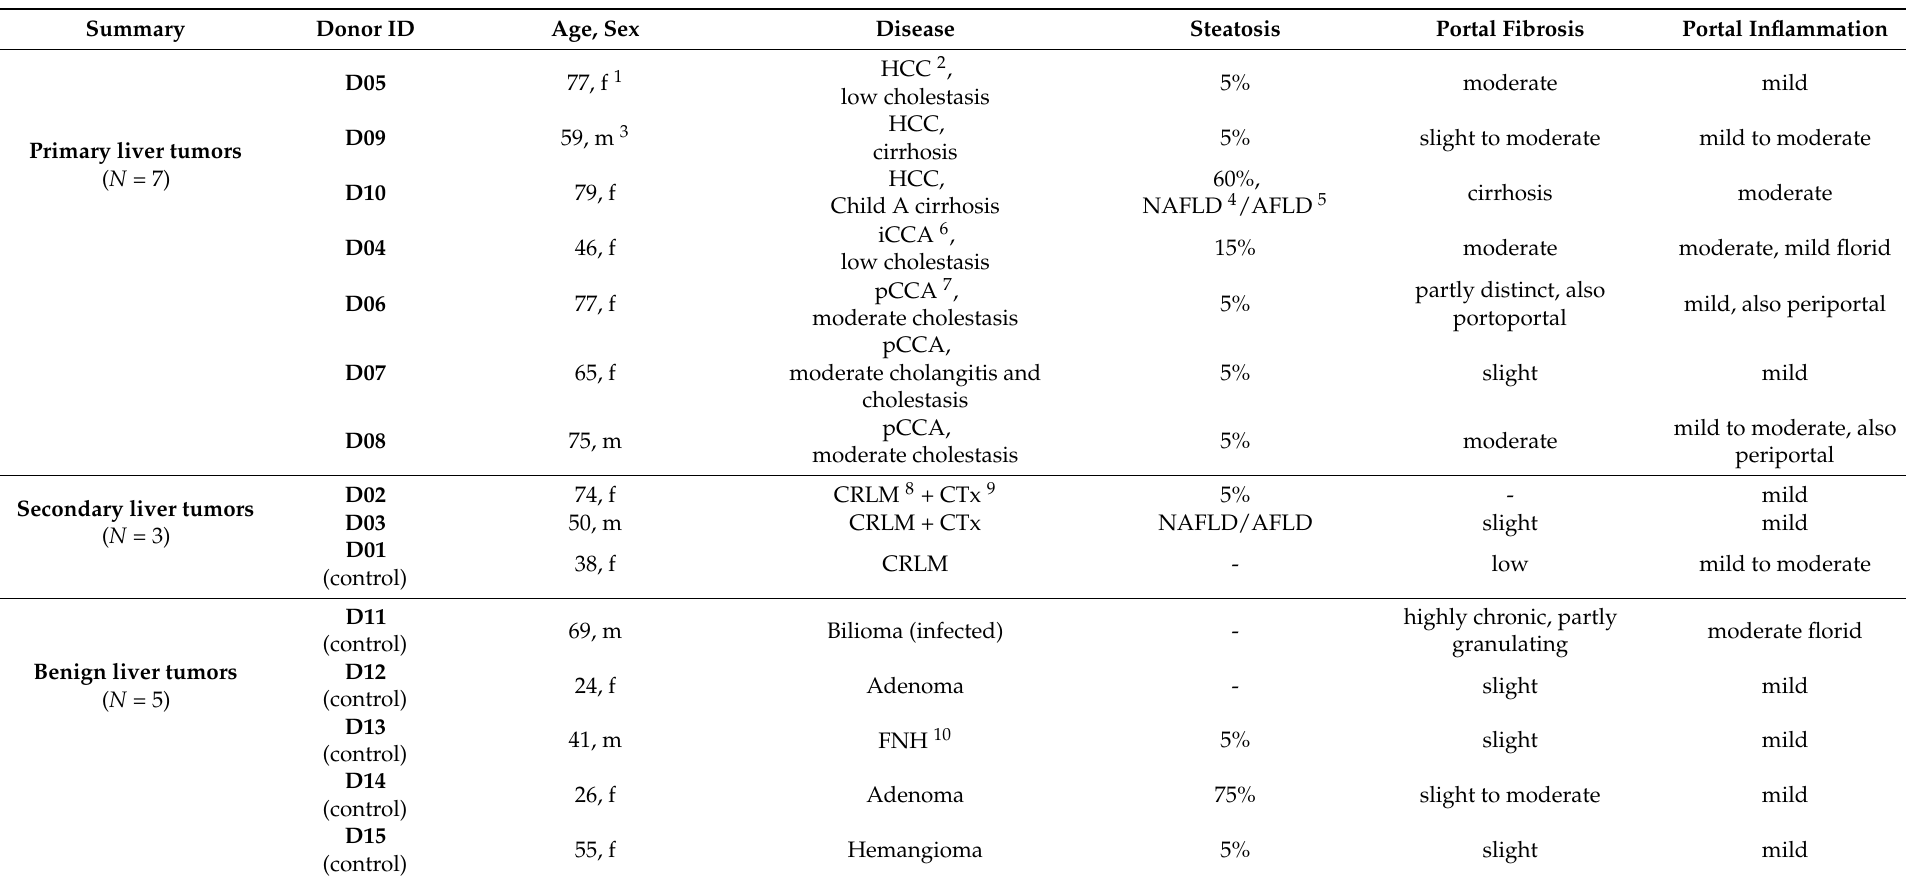
Table 1. Summarized donor data for liver tissue samples used for immunohistochemical staining. Donor data are summarized based on the underlying disease. In addition, age; sex as well as histopathological findings for steatosis, fibrosis and inflammation of the donors are indicated. For details on clinical data, see Table S1 in the Supplementary